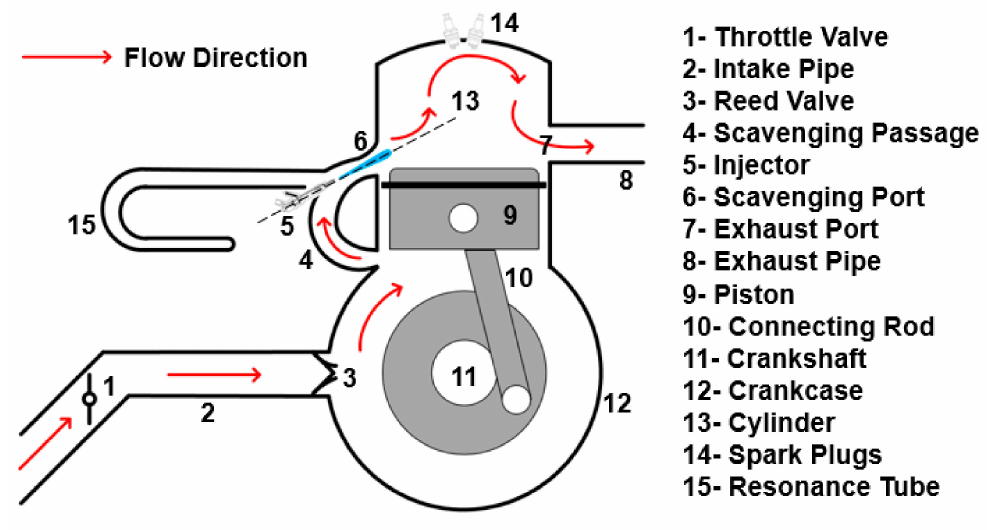
Figure 8. Schematic diagram of the retrofitted engine.